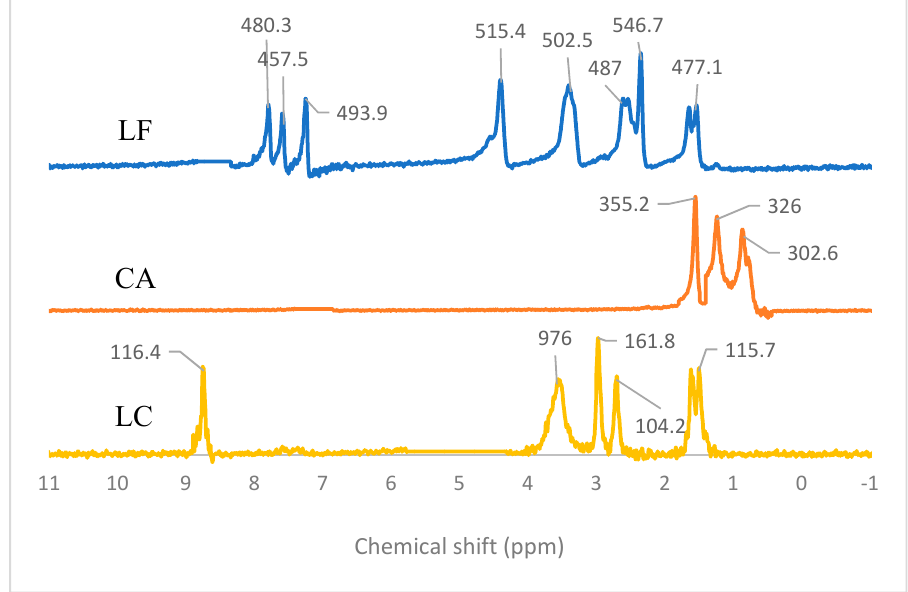
Figure 6. 1 H NMR spectra of levofloxacin (LF) and citric acid (CA) in CDCl 3 solution, and levofloxacin-citrate (LC) in D 2 O.